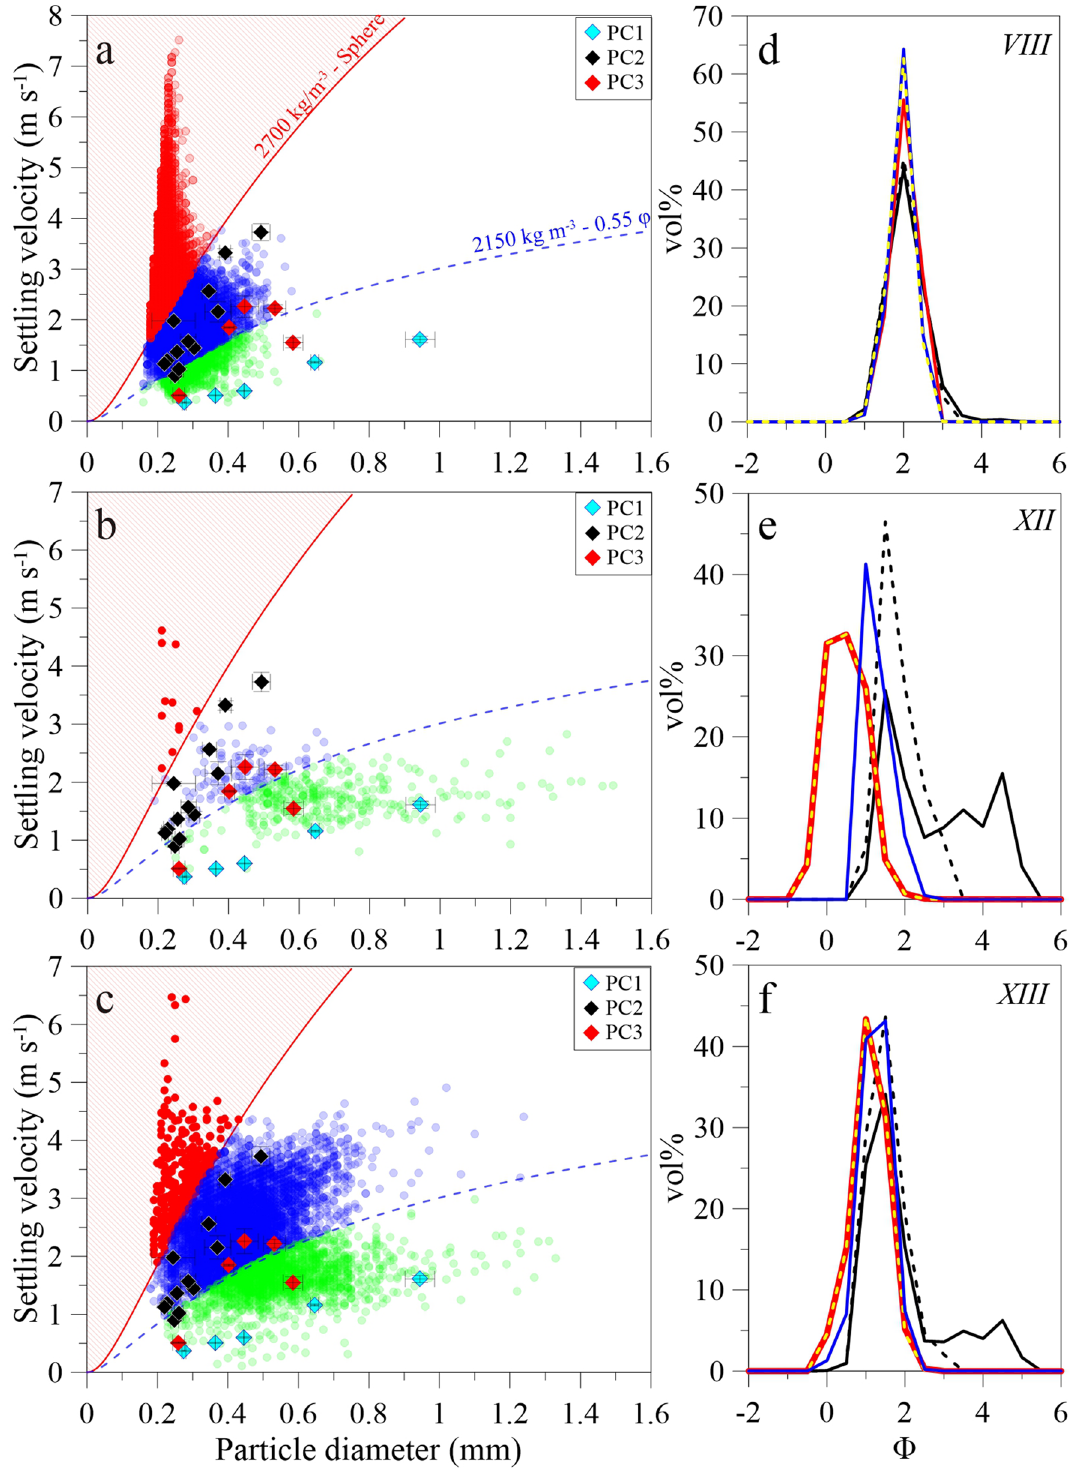
Figure 3. Particle size and velocity measured during the tephra-fallout events ( a ) VIII, ( b ) XII and ( c ) XIII. Red and blue dashed lines indicate the margin trend and the individual-particle trend, respectively. Diamonds indicate aggregate estimates retrieved based on high-speed camera analyses by Diaz-Vecino et al. 33 (blue: Ash Cluster—PC1; black: Coated Particle—PC2; red: Cored Cluster—PC3). Vol% GSD of LPM records and obtained from BETTERSIZER analysis for events VIII, XII and XIII are shown in ( d ), ( e ) and ( f ), respectively. Red: raw LPM data; dashed yellow: LPM data without margin fallers; Blue: LPM filtered for single settling particles; Black: raw BETTERSIZER distributions; Dashed Black: GSDs BTS of particles > 0.15